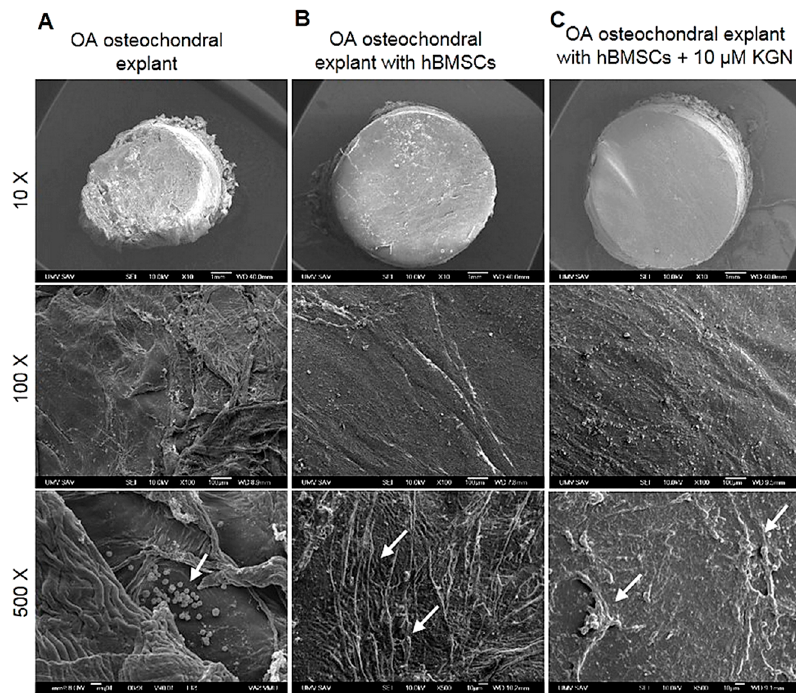
Figure 4. Scanning electron microscopy (SEM) at different magnifications showing the surface of ( A ) OA osteochondral explants alone (white arrows indicate inflammatory cells) and after 21 days of co-cultivation with ( B ) hBMSCs (white arrows indicate the typical spindle-shape morphology of cells) and with ( C ) hBMSCs with 10 µM KGN (white arrows indicate spherical aggregates).